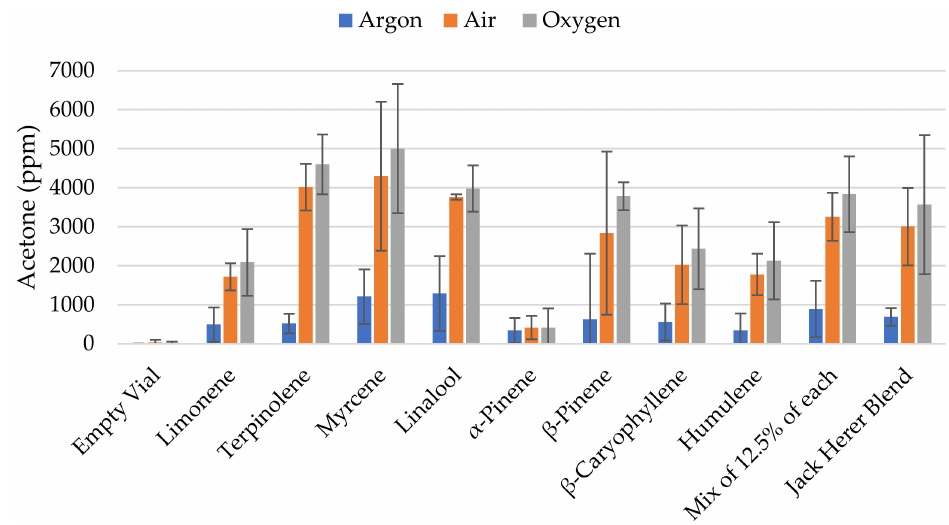
Figure 2. Acetone detection in samples (error bars show the 95% confidence interval).